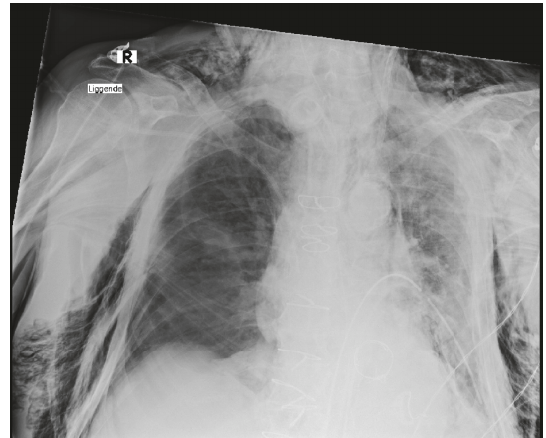
Figure2:ChestX-rayisshowingmassivesubcutaneousemphysema after CICO and reestablishing a surgical